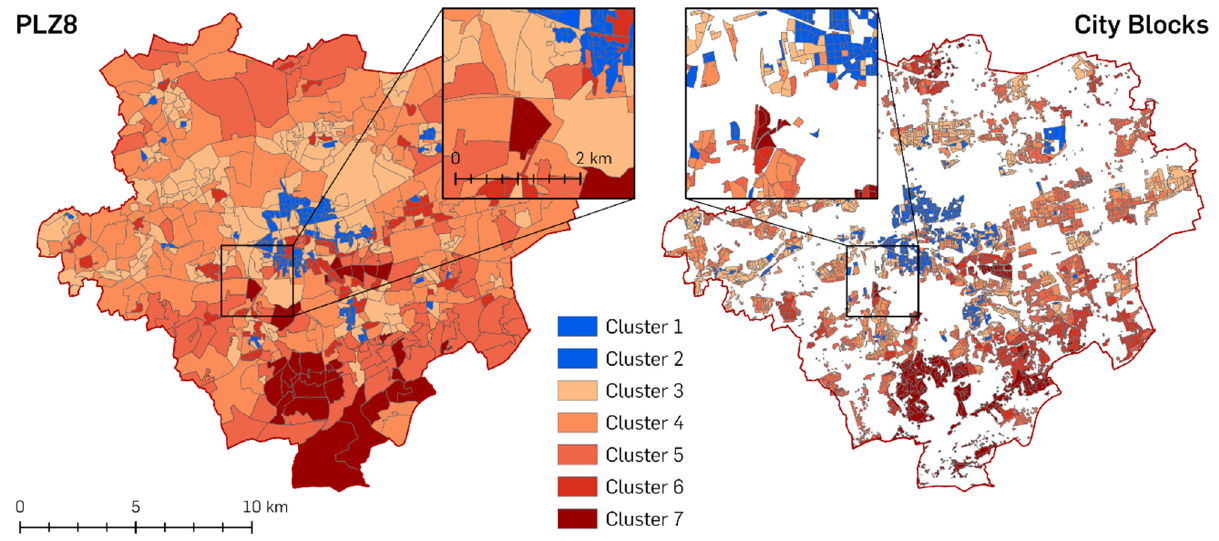
Figure 10. Multivariate clusters for the city of Dortmund with PLZ8 and city blocks, the two lowest clusters in blue (Data Sources: [22,23,25]).